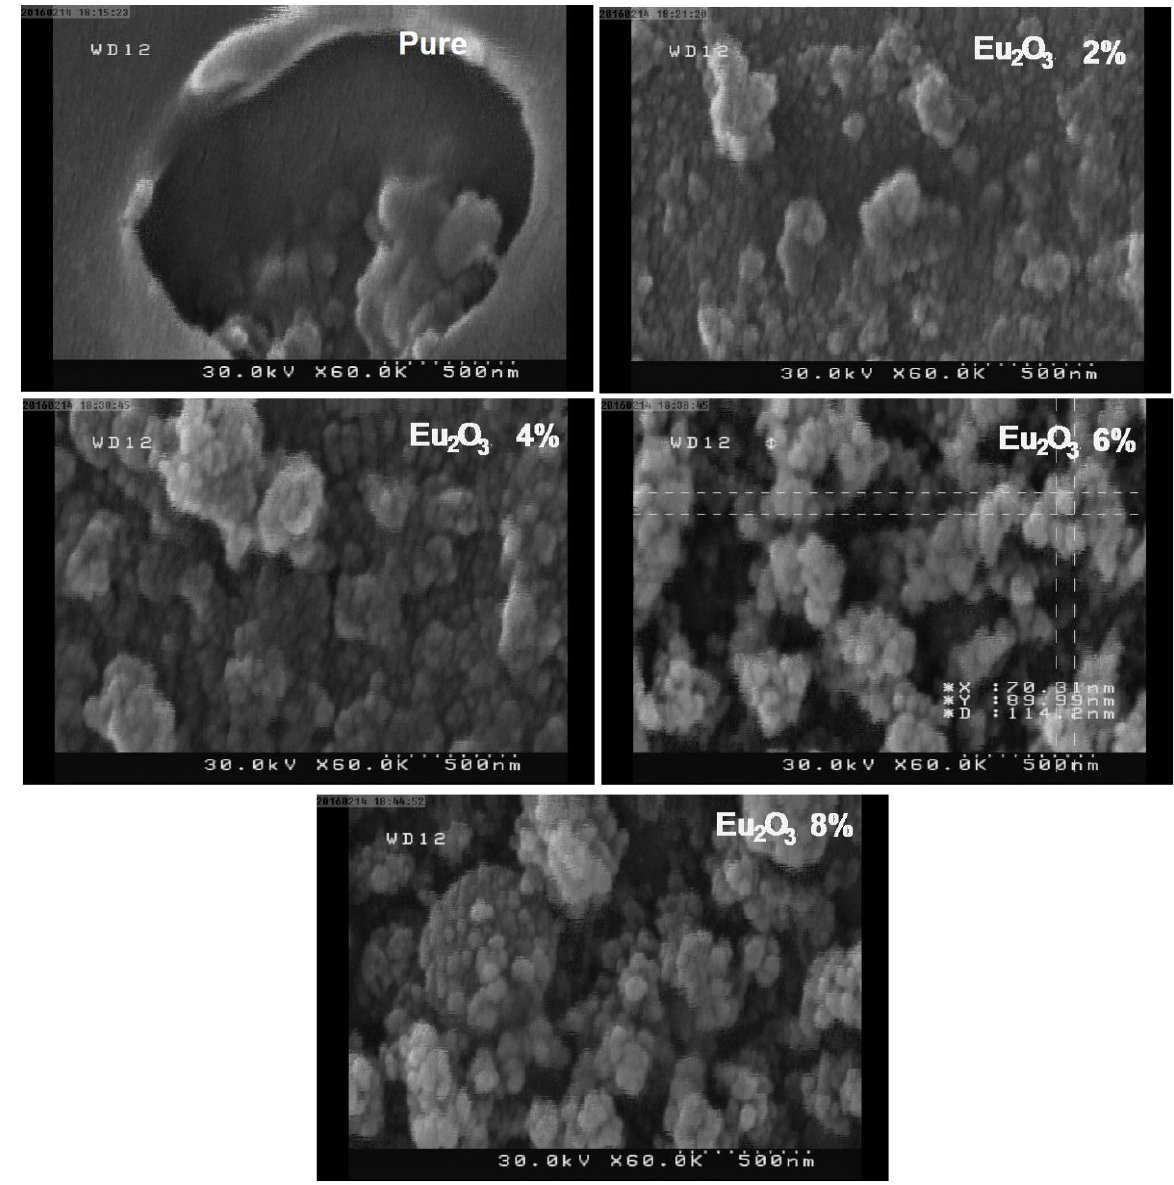
Fig.2: FESEM for V